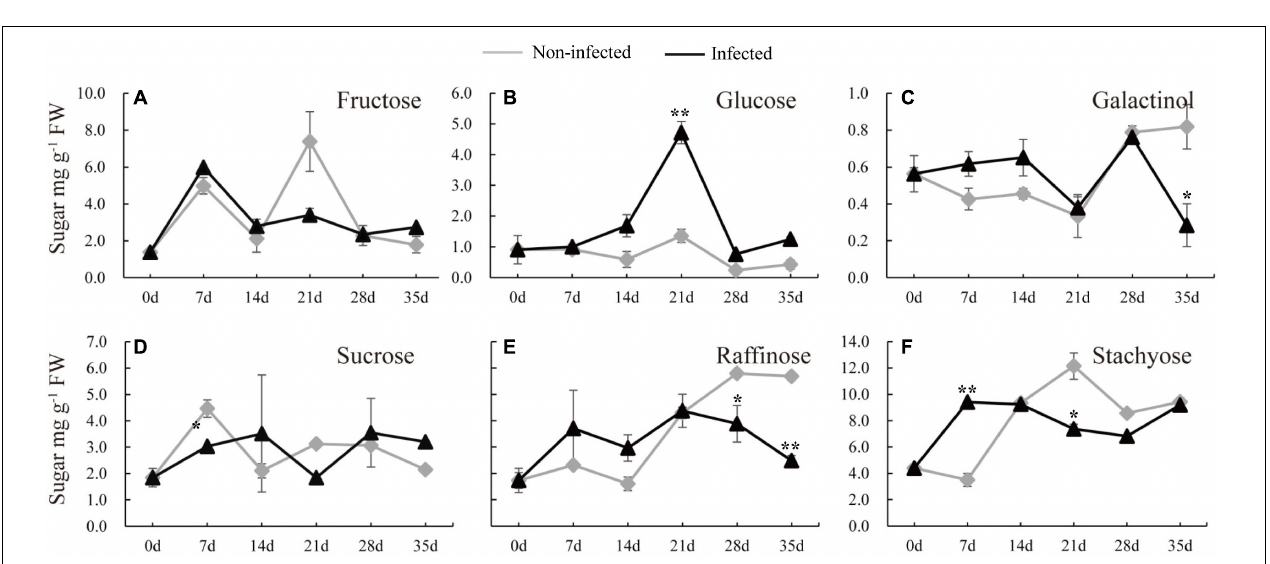
FIGURE 1 | Infection of M. incognita to cucumber roots. (A) Control cucumber roots without nematode infection. (C) Galls (blue arrows) are induced in roots by M. incognita . (B,D) Are the close-up views of sections marked in (A) (red) and (C) (blue) regions. Blue arrows in (D) indicate root knots or galls induced by nematodes. (E) The anatomic structure of a gall. Red pentagrams indicate the giant cells (GCs). (F1–F5) RKN life cycle inside cucumber roots, J2 (F1) -J3 (F2 )-J4 (F3,F4) -eggs (F5) . Black arrows indicate the female nematodes with a pear-shaped body. Black pentagram indicates the eggs produced by adult nematodes.